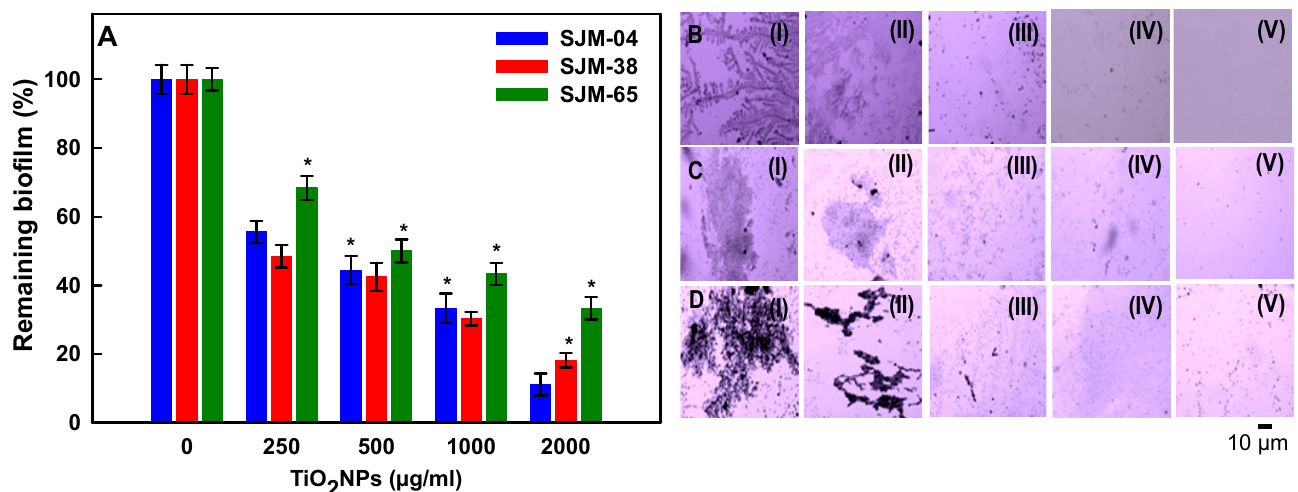
Figure 6. Reductions in biofilm formation after treatment with TiO 2 NPs at 250, 500, 1000, or 2000 µg/mL for 24 h (Panel A ). Error bars denote standard deviations of triplicate samples ( A ). Microscopic images showing reduced biofilm formation by SJM-04 ( B ), SJM-38 ( C ), and SJM-65 ( D ) after treatments with TiO 2 NPs at 0 ( I ), 250 ( II ), 500 ( III ), 1000 ( IV ), or 2000 µg/mL ( V ). ‘*’ denotes the statistical difference at p ≤ 0.05 between control and treated groups.